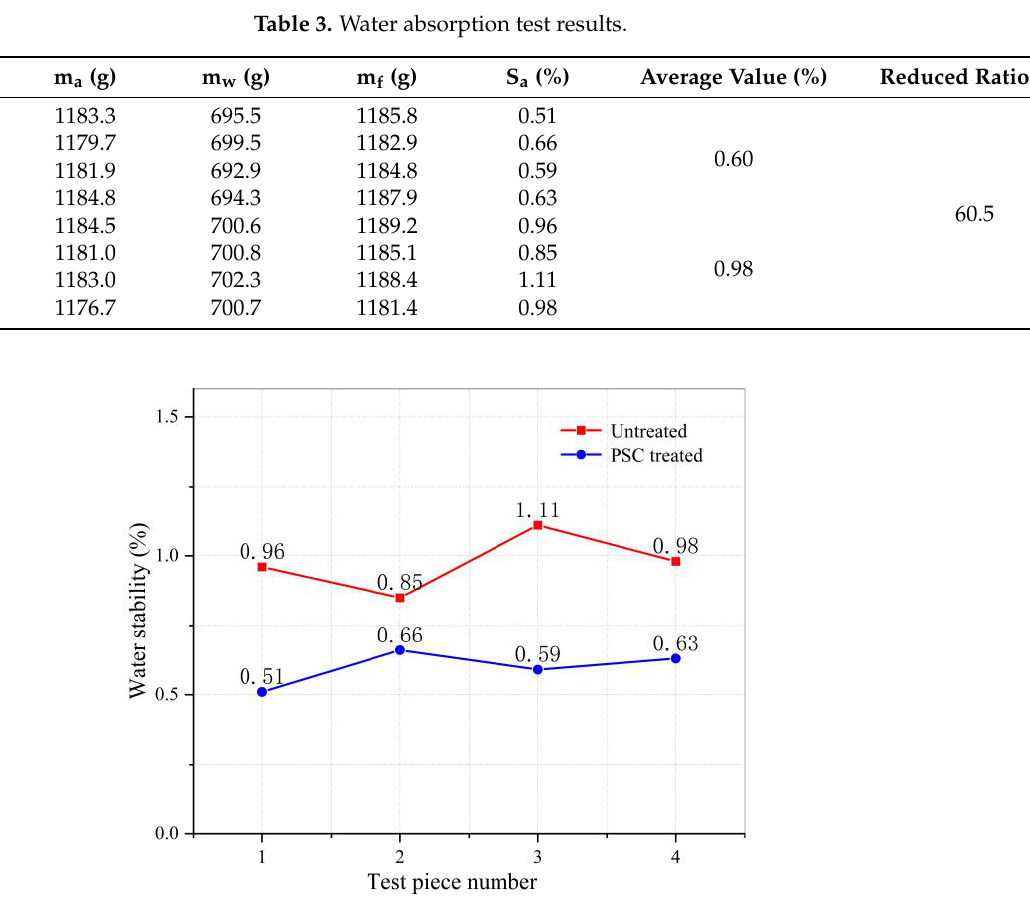
Figure 8. Point line graph of water absorption test results.